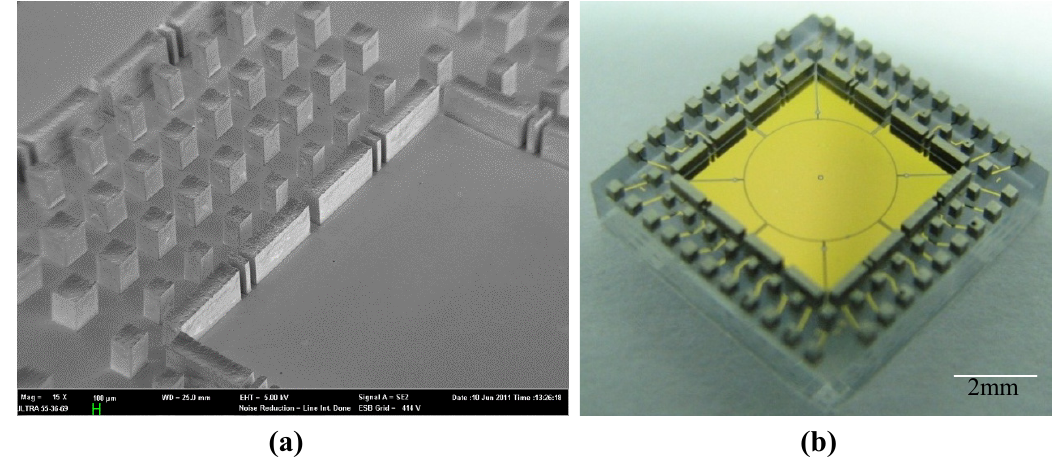
Figure 9. Fabrication results of the bottom stator: (a) SEM image of the integrated nickel structures, in thickness of about 500 μ m, after removal of the SU-8 mold; (b) One die of the fabricated bottom stator, whose size is 10 × 10 mm 2 .